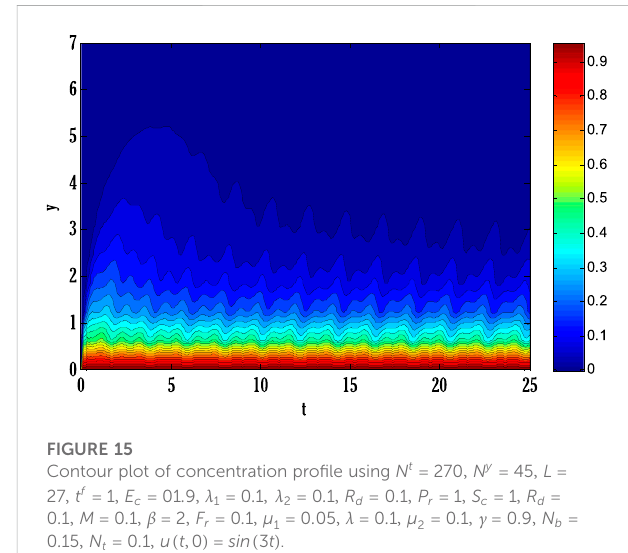
FIGURE 13 Contour plot ofvelocity pro fi le using N t (cid:2) 270 , N y (cid:2) 45 , L (cid:2) 27 , t f (cid:2) 1 , E c (cid:2) 01 . 9 , λ 1 (cid:2) 0 . 1 , λ 2 (cid:2) 0 . 1 , R d (cid:2) 0 . 1 , P r (cid:2) 1 , S c (cid:2) 1 , R d (cid:2) 0 . 1 , M (cid:2) 0 . 1 , β (cid:2) 2 , F r (cid:2) 0 . 1 , μ 1 (cid:2) 0 . 05 , λ (cid:2) 0 . 1 , μ 2 (cid:2) 0 . 1 , γ (cid:2) 0 . 9 , N b (cid:2)